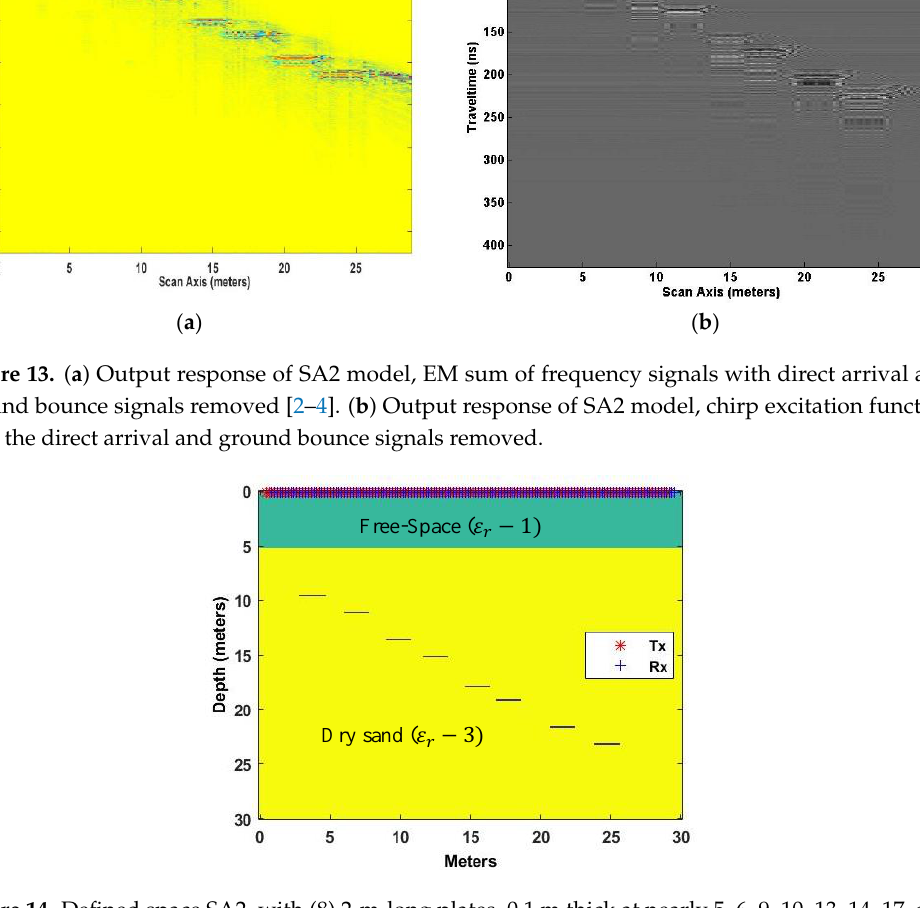
Figure 14. Defined space SA2, with (8) 2-m-long plates, 0.1 m thick at nearly 5, 6, 9, 10, 13, 14, 17, and 18 m with Tx/Rx pair 5 m above ground [5].